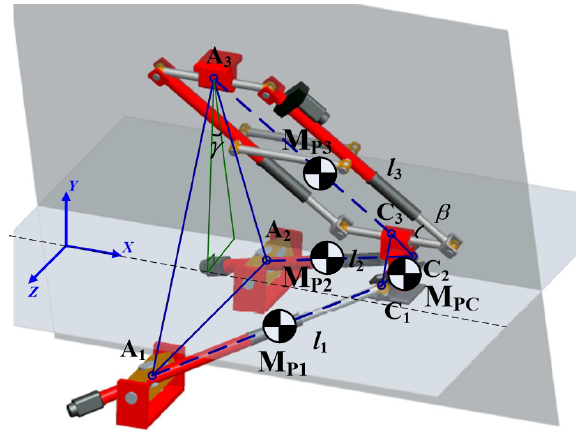
Figure 6. Simplified 3-SPS